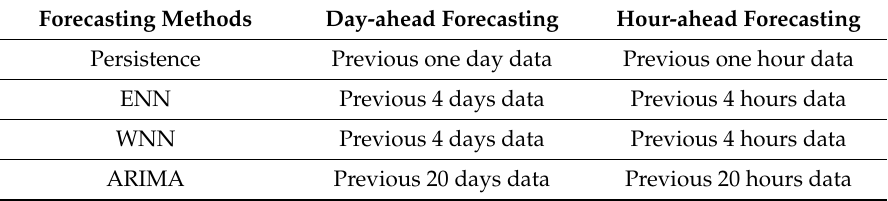
Table 1. Input data for each forecasting model.